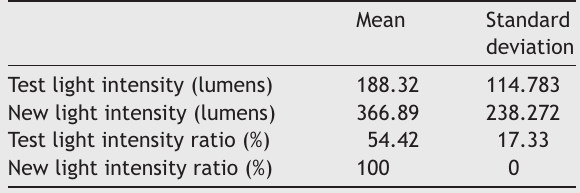
Mean and standard deviation of light intensity, and test battery light intensity ratio in relation to new batteries. Mean Test light intensity (lumens)